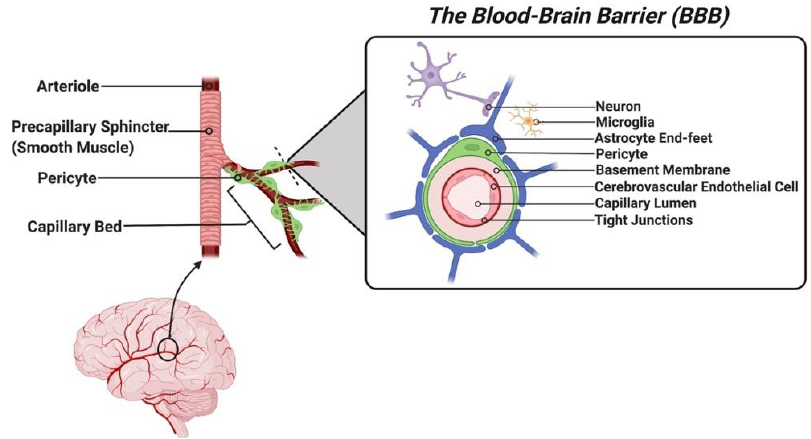
Figure 1. Schematic representation of the anatomical structure of the blood – brain barrier (BBB) and the accompanying neurovascular unit. Note the abluminal CEC surface is ensheathed by a basement membrane embedded with pericytes. ( Created with Biorender.com. )